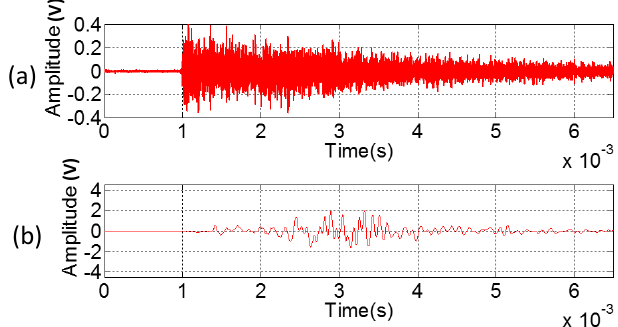
Figure 5. Signals collected during laser microwelding: ( a ) acoustic-emission (AE) signal; ( b ) audible sound.